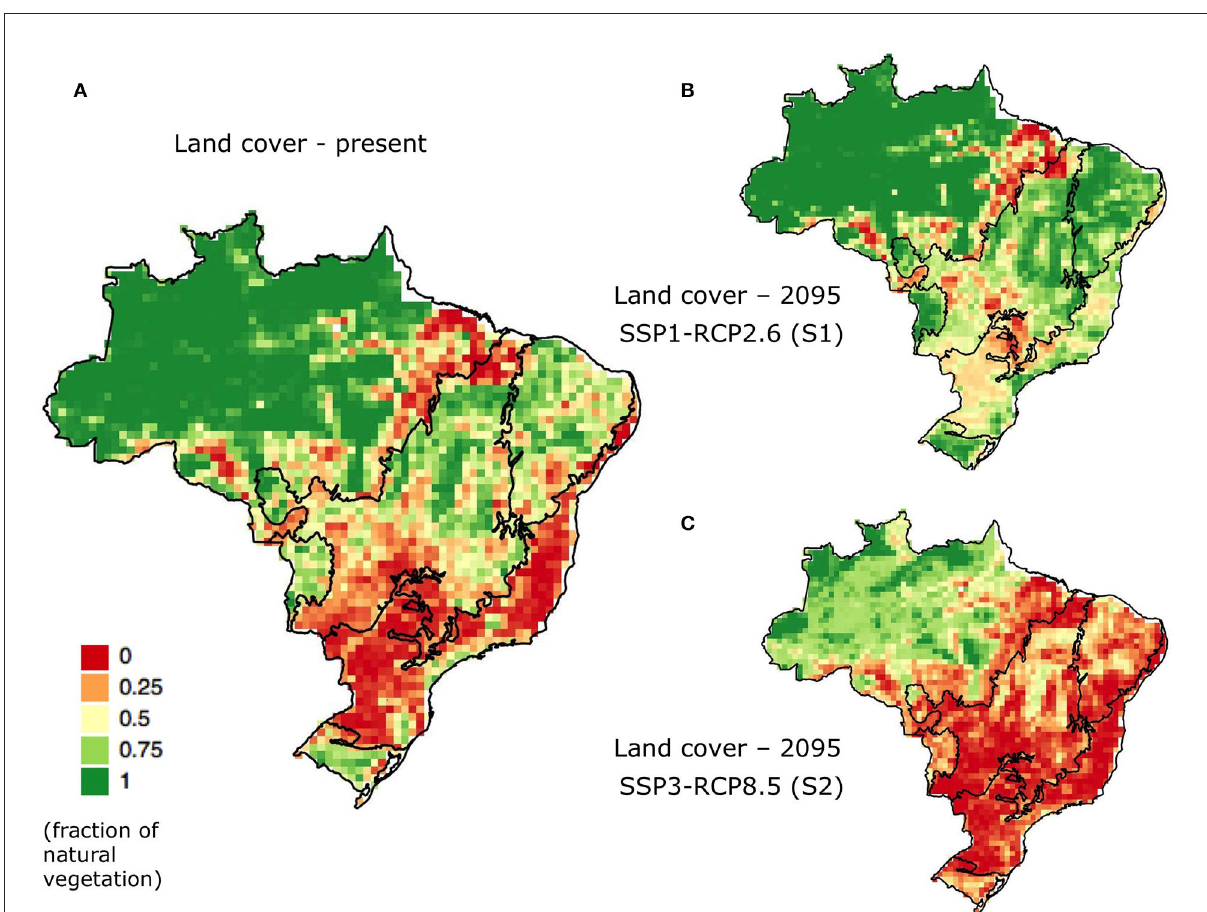
FIGURE2 Land cover (fraction of natural area) for (A) the first time step of the model and at the end of the simulation to (B) SSP1-RCP2.6 (S1) and (C) SSP3-RCP8.5 (S2).